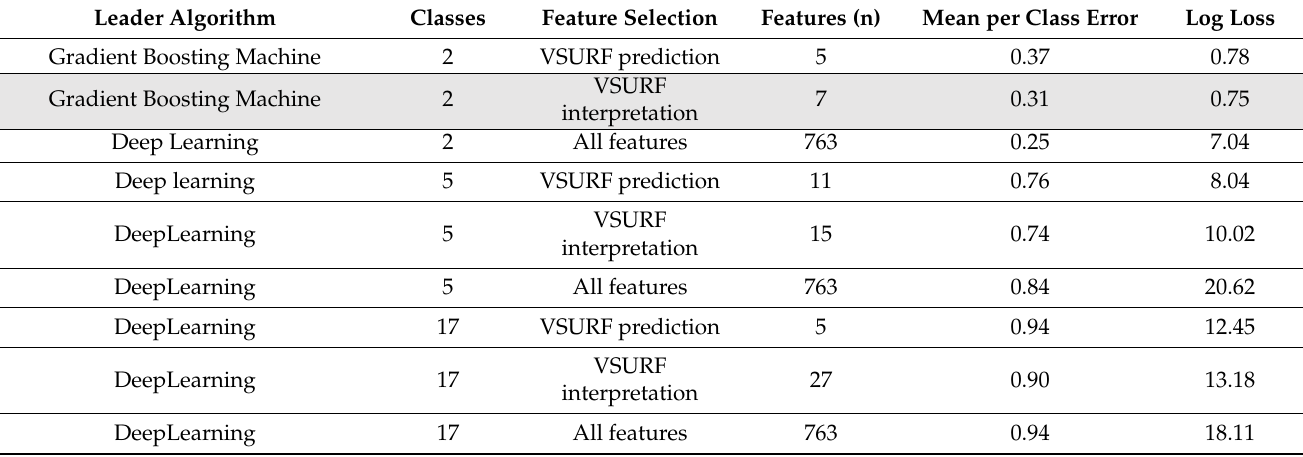
Table 3. Leaders of all AutoML model runs validated on an external 20% test data set. Grey row shows the overall best model from all classification scenarios and feature